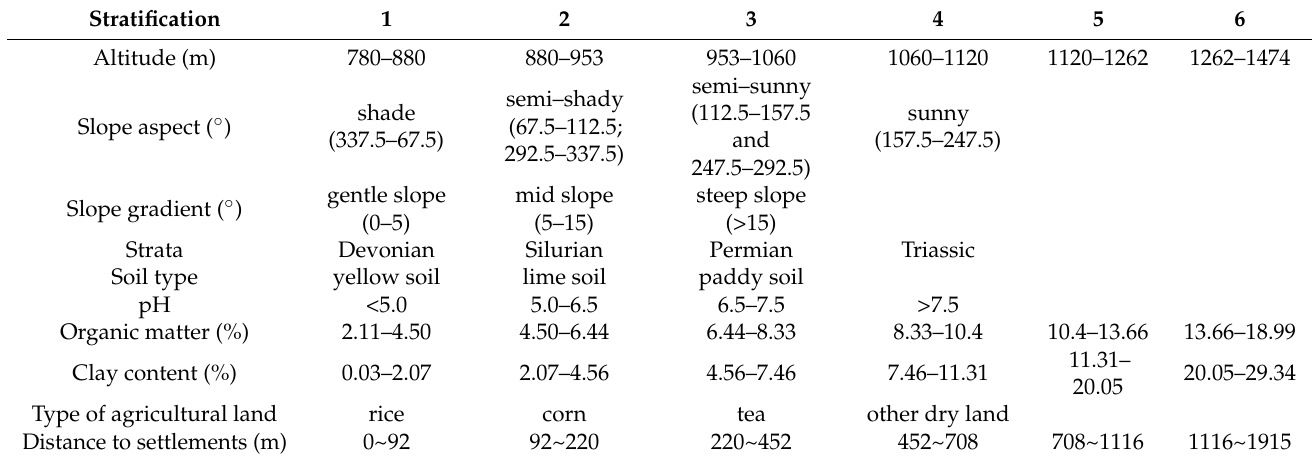
Table 4. The stratification of the influencing factors used in the geographic detector.